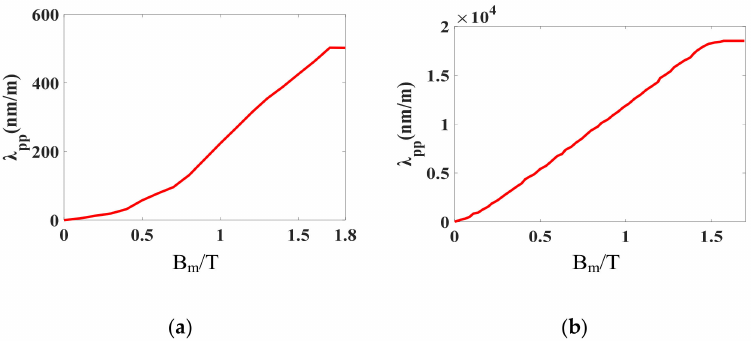
Figure 10. Single-valued magnetostriction curves: ( a ) Rolling direction; ( b ) transverse direction.